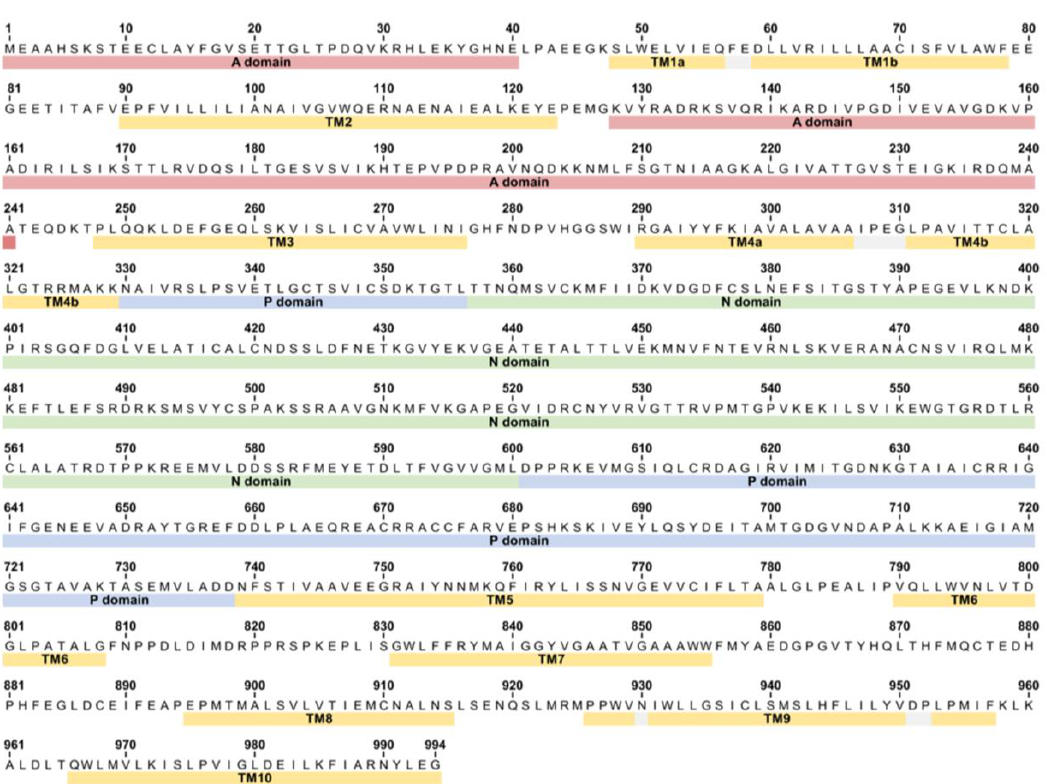
Figure B1. Sequence of SERCA1a from rabbit ( Oryctolagus cuniculus) showing the location of all major domains.